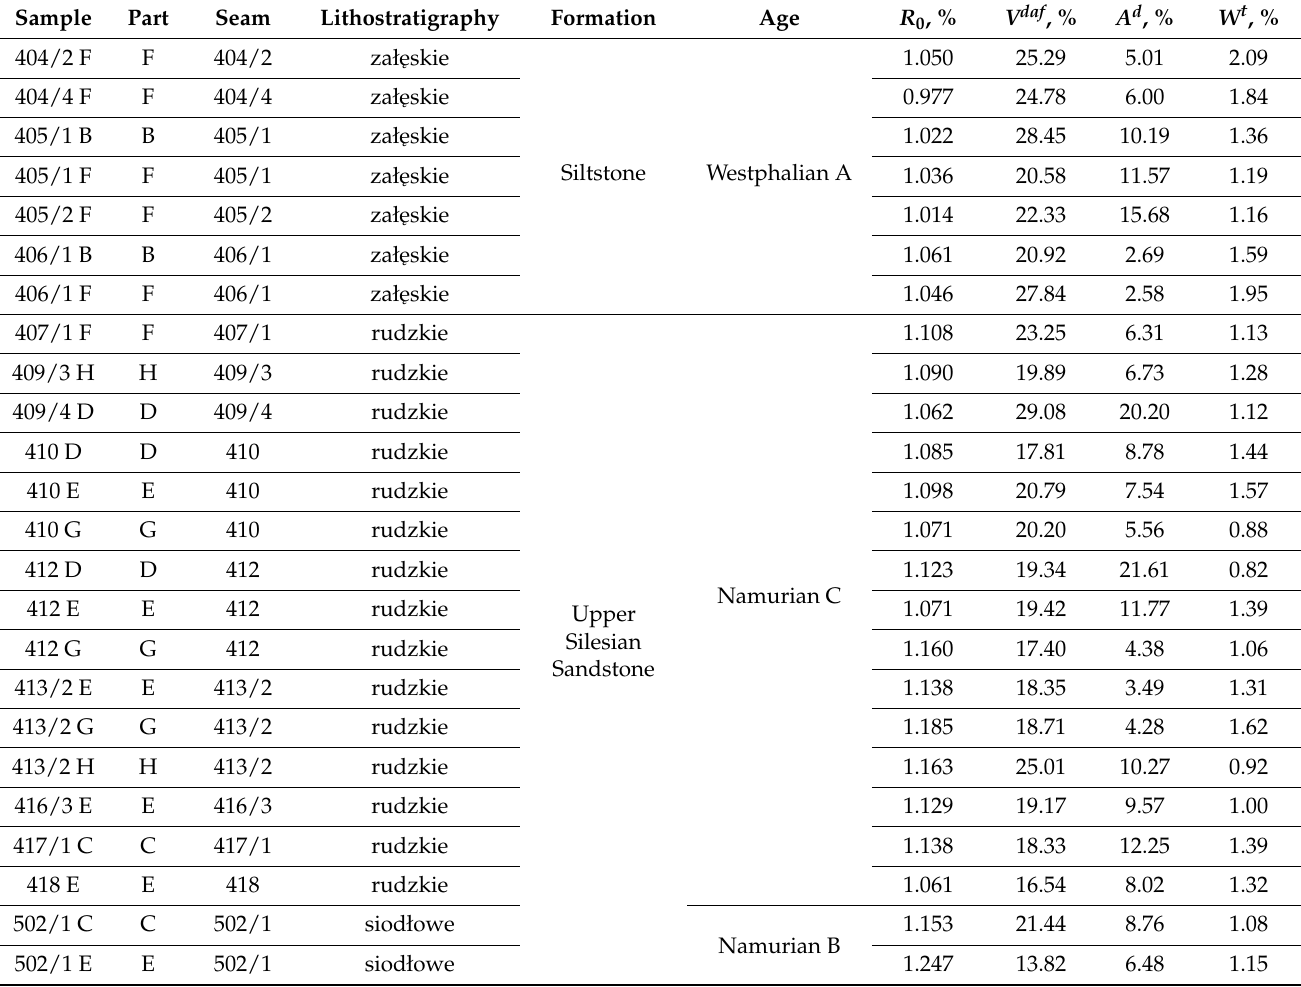
Table 1. Designation of coal samples, place of sampling, average vitrinite reflectance and technical